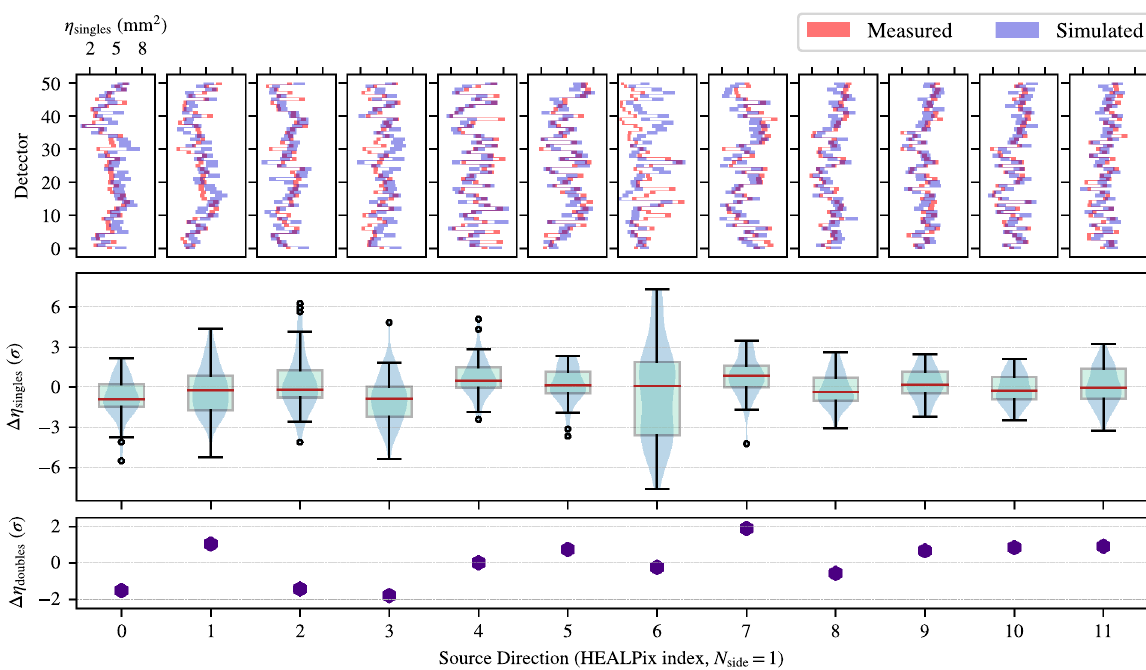
Figure 4. Detector response characterization. MiniPRISM far-field 662-keV gamma-ray detector response characterization (singles and doubles) at 12 source directions around 4 π defined by the HEALPix discretization 1 . Measurements were performed with the scanning system described in the text, using a scheme with N side = 137 182.5 µ Ci Cs at 110 cm from the center of the detector array and 5-min acquisitions at each source direction. Simulations were performed using Geant4. The top pane shows the measured (red) and simulated (blue) 2 full-energy singles effective area (mm ) of individual detector elements, with shading denoting uncertainties (discussed in the text), across the 12 source directions. The middle pane shows a box-and-whisker plot of the per-detector effective area differences between measurement and simulation in the top plot, expressed in units of Gaussian z -scores ( σ ). The boxes and whiskers describe the interquartile range (IQR) and 1.5 ICR, × respectively, and points indicate outliers outside the extent of the whiskers. A red line is drawn in each box to denote the median of the data. Finally, a violin plot is overlaid to provide a sense of the distribution (via a 1D kernel density estimator) of the data across the vertical dimension. The bottom pane shows the doubles effective area differences between measurement and simulation of the entire detector array, in units of Gaussian z